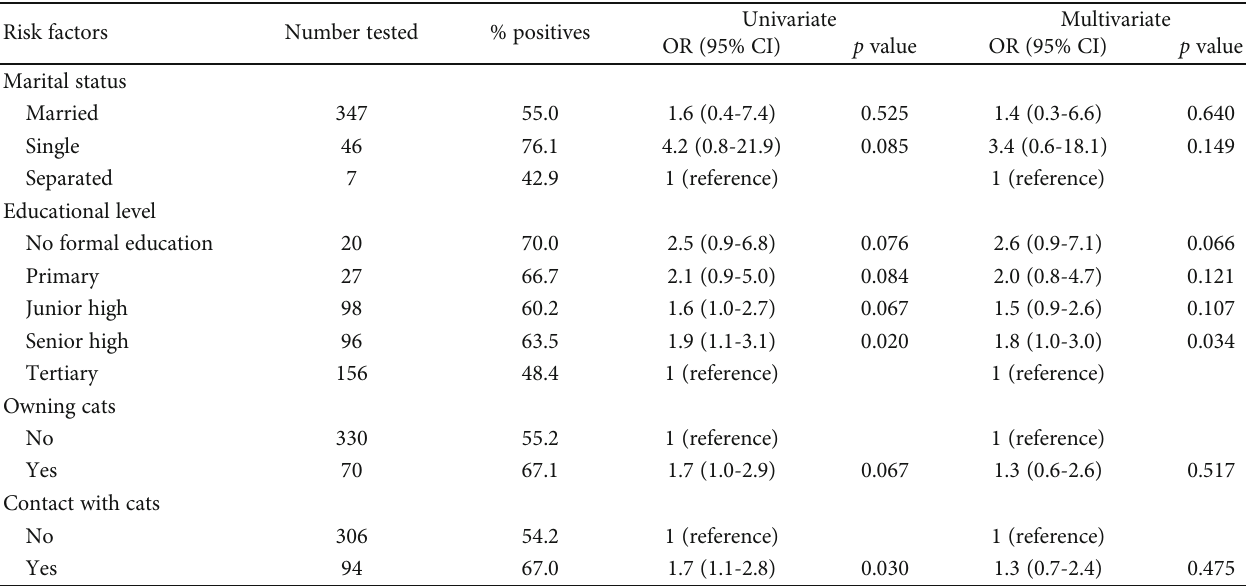
Table 3: Bivariate and multivariate analyses of risk factors signi fi cantly associated with Toxoplasma gondii seroprevalence in this present